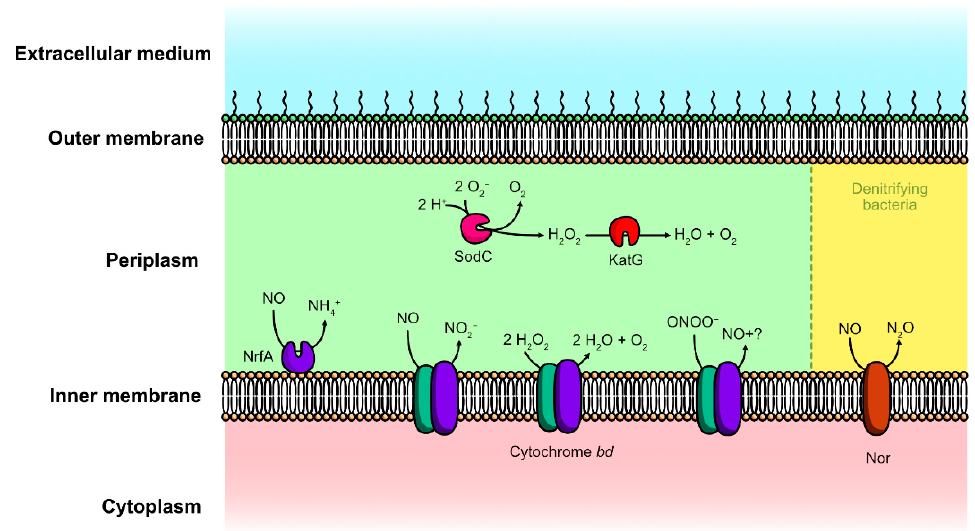
Figure 2. Various mechanisms used by Gram-negative bacteria to detoxify ROS and RNS in the periplasmic space.